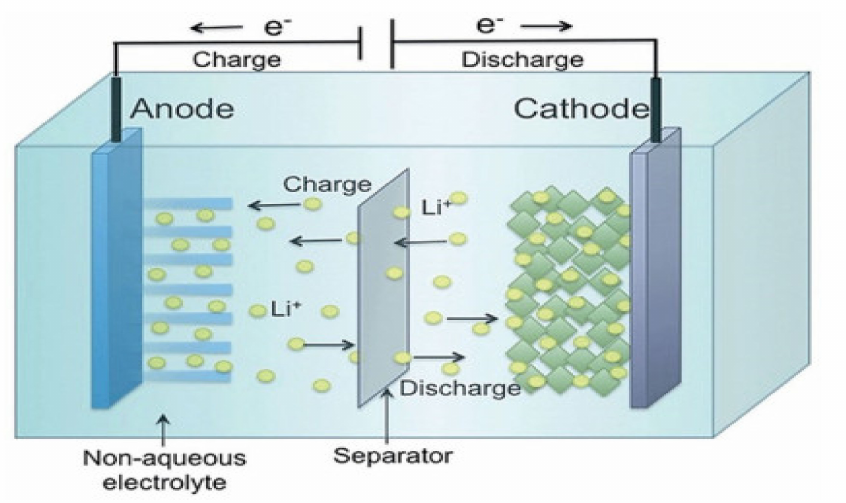
Figure 2. The LIBs components and reactions